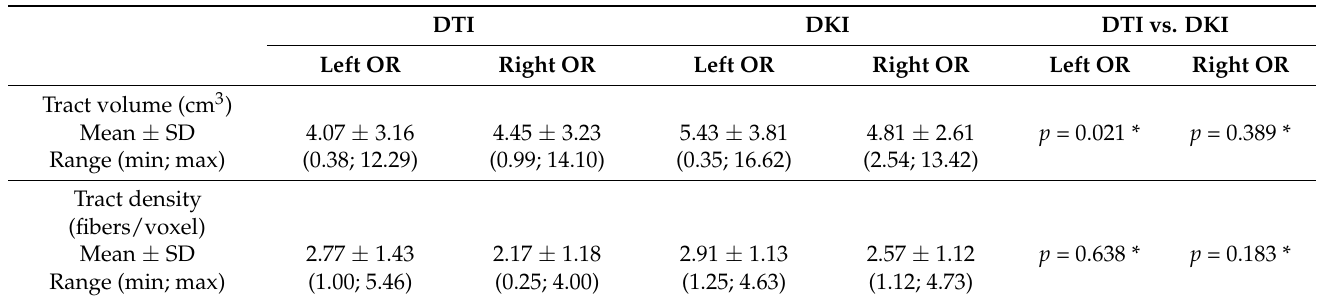
Table 4. Results of fiber tractography of the OR in patients.